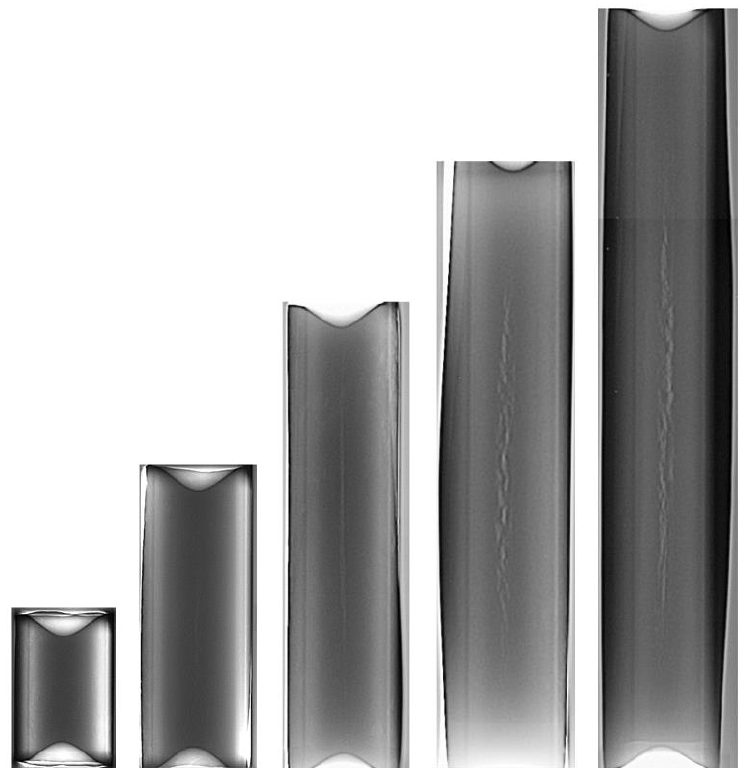
Figure 17. Exemplary roentgenograms of the rotationally compressed samples; dimensions of the samples—diameter 30 mm, initial length (from the left) 30, 60, 90, 120 and 150 mm.